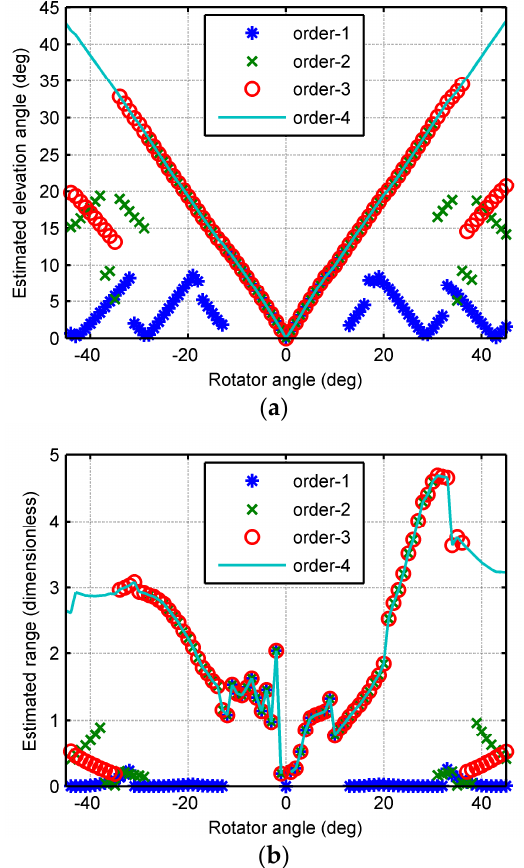
Figure 6. Estimated results by variational phase difference orders. ( a ) The elevation angle; ( b ) the range.